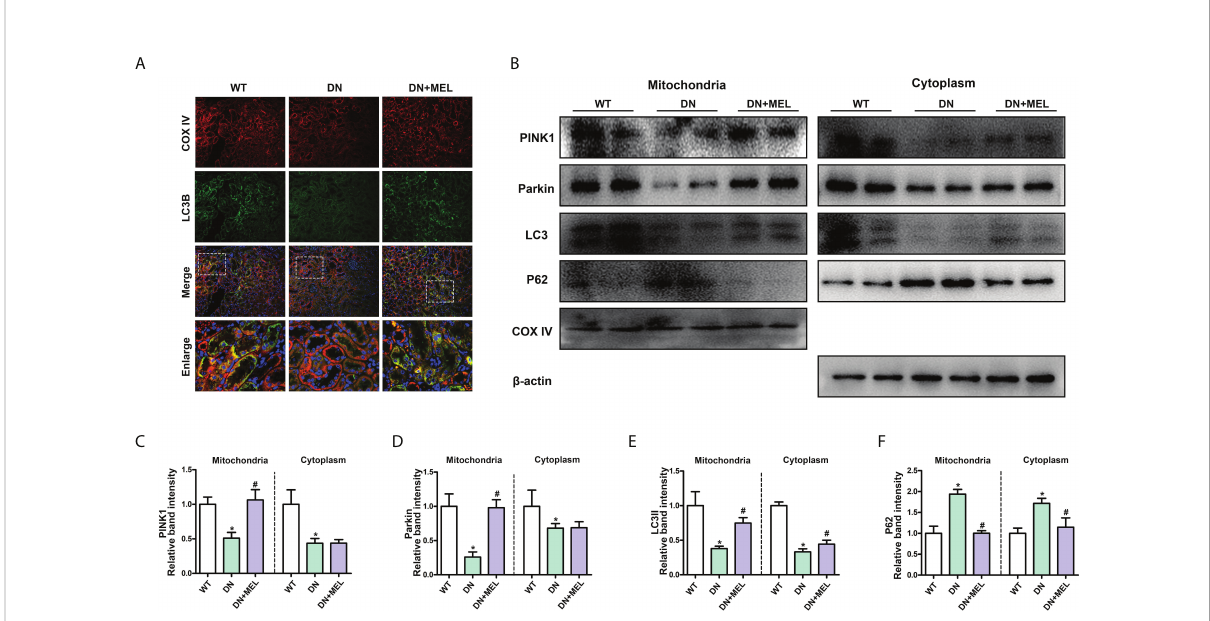
FIGURE 4 The effects of melatonin on mitophagy in the kidneys of DN mice. Costaining for COX IV (A, upper panel) and LC3B (A, second panel) observed the mitophagy changes. Western blot analysis of PINK1, Parkin, Parkin, LC3II, and P62 protein expression in mitochondria (left panels) and cytoplasm (right panels) (B) . Quantitative analysis of PINK1 (C) , Parkin (D) , LC3II (E) , and P62 (F) . The values are the mean ± SD. n = 6/group. *p < 0.05 compared with the control group; # p < 0.05 compared with the DN